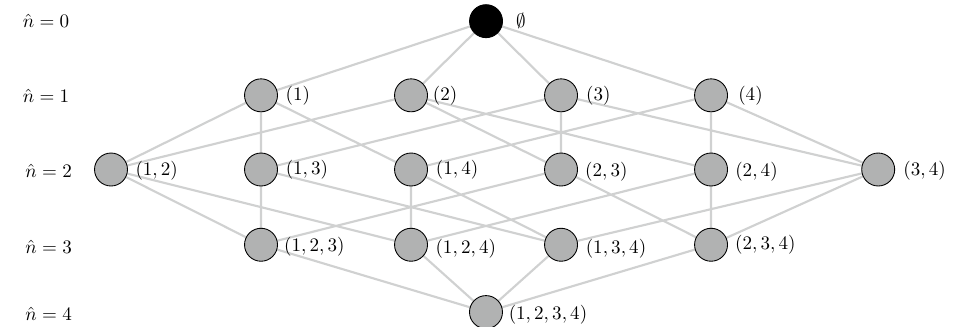
Figure 1. FSS search space: The figure provides the FSS search space I for n = 4 features. It comprises 2 n − 1 non-empty feature subsets (gray nodes) from which one has to be selected. The empty set ∅ (black node) is typically omitted. The feature subsets are organized row-wise according to their feature set size ˆ n . The FSS search space is shown in form of a Hasse diagram. That is two nodes are connected via an edge if both of them can be translated into the other by adding or removing a